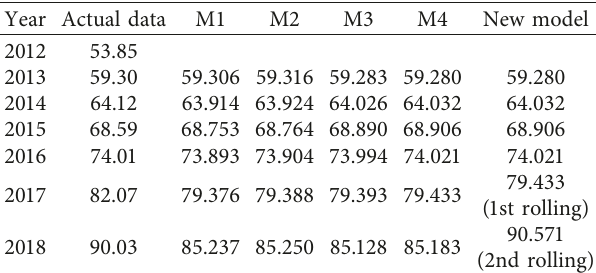
Table 6: Results of simulation and prediction from the five grey models.